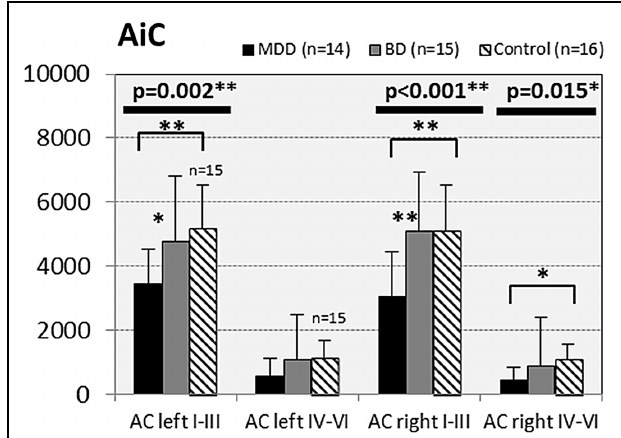
FIGURE 5 | Numerical densities of GS-expressing glial cells (ACs and OLs) in the AiC of subjects with MDD, BD, and controls. Compared with controls the density of GS-expressing ACs is significantly reduced in MDD cases (AiC left I–III, p = 0.002; AiC right I–III, p = 0.001; AiC right IV–VI, p = 0.015).